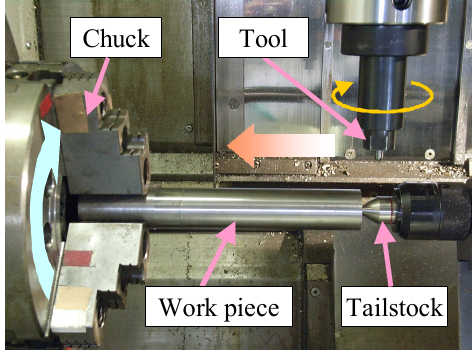
Figure 3. The experimental test stand.